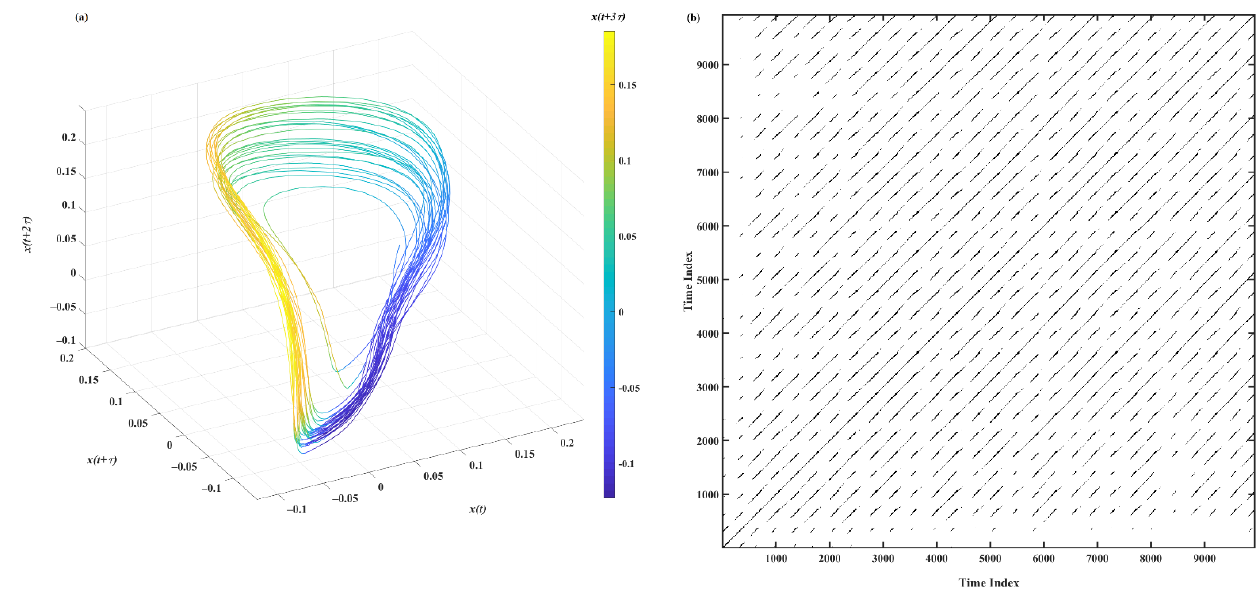
Figure 7. An example of ( a ) time-delay-reconstructed attractor and ( b ) the resulting RP obtained from one of the PPGs recorded in this study.